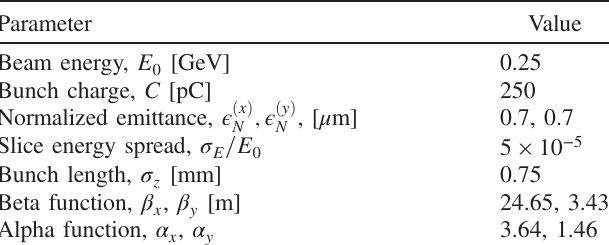
TABLE II. Beam parameters at the entry of the BC1 in LCLS. Parameter